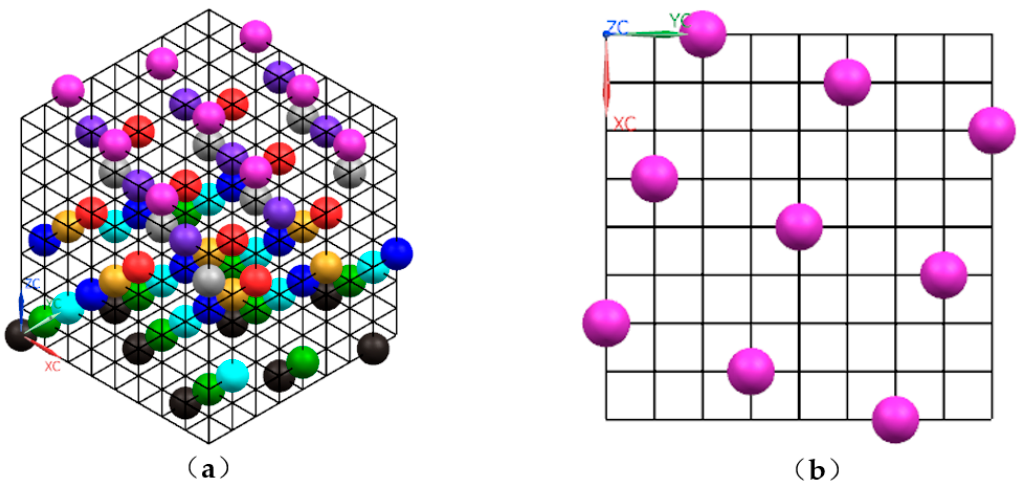
Figure 5. The distribution of test points: ( a ) optimal Latin hypercube design (OLHD) in a 3D space; ( b ) OLHD in a 2D space.